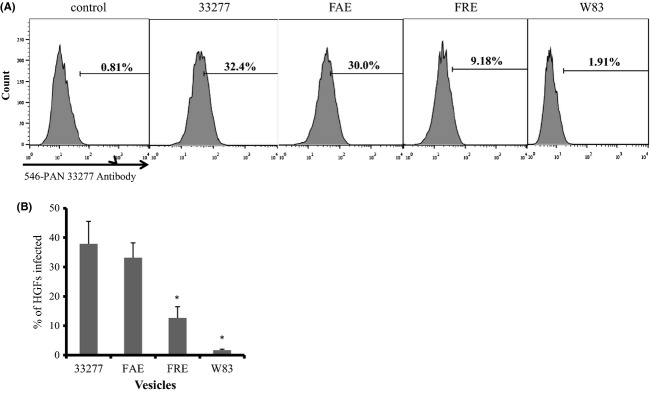
Invasive efficiencies of Porphyromonas gingivalis vesicles using human gingival fibroblasts (HGFs). HGFs were infected with P. gingivalis vesicles derived from 33277, fimA mutant (FAE), fimR mutant (FRE), and an afimbriated strain (W83), respectively. Four hours after an initial exposure, the infected HGFs were analyzed by flow cytometry. (A) Representative FACS scatter plots for quantification of the infected HGFs with vesicles of different P. gingivalis strains. The percent of infected HGFs is indicated. (B) Bars are shown with standard deviations (n = 3) and represent the percent of HGFs with internalized vesicles. An asterisk indicates a significant difference between the % HGFs infected with 33277 vesicles compared to the % infected using the other P. gingivalis strains (*P < 0.05 by t-test).